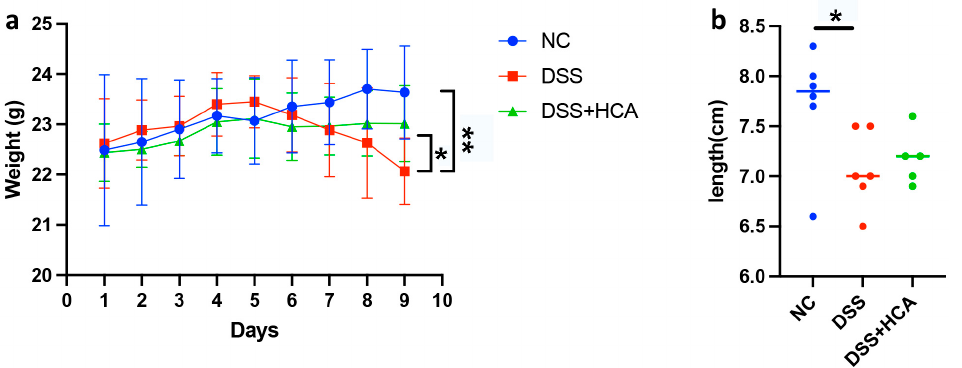
Figure 11. HCA attenuates DSS-induced colitis. ( a ) Body weight changes during the course of the experiment. ( b ) The colon lengths of mice as measured at sacrifice on day nine. Comparisons among the control, DSS, and DSS + HCA groups were performed using Mann–Whitney tests. * p < 0.05; ** p < 0.01. NC: normal control; DSS: dextran sodium sulfate; HCA: hyocholic acid.